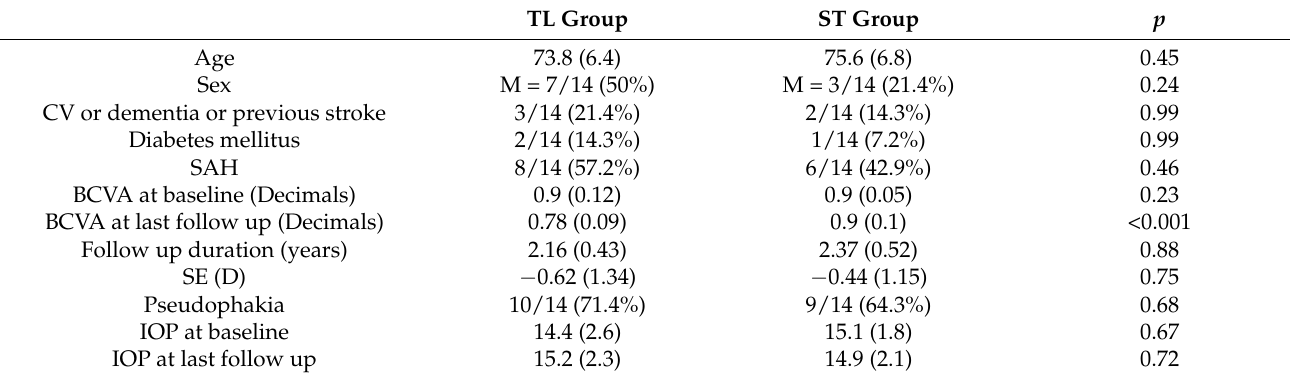
Table 1. Anamnestic and clinical characteristics of study groups. Quantitative variables are described as median and IQR in brackets. BCVA = best corrected visual acuity; CV = cerebral vasculopathy; IOP = intraocular pressure; SAH = systemic arterial hypertension; SE = spherical equivalent.